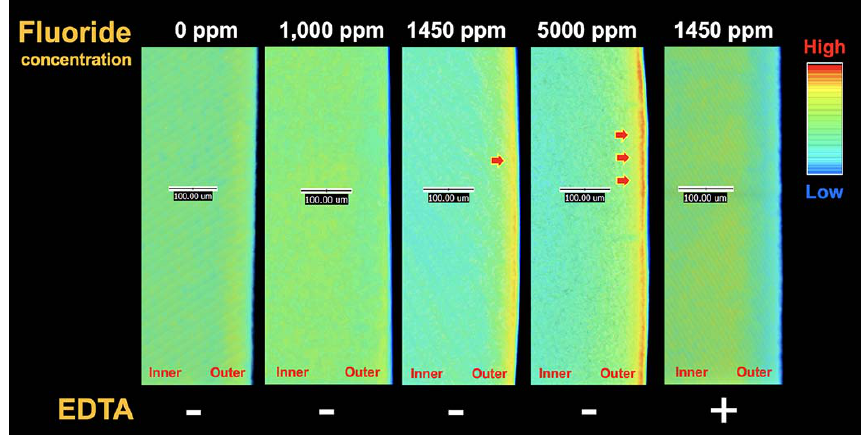
Figure 5 m CT image of superficial mineral deposition on root dentin. Mineral gain on the superficial layer of fluoride-treated samples is clearly seen in a dose- dependent manner as indicated by red